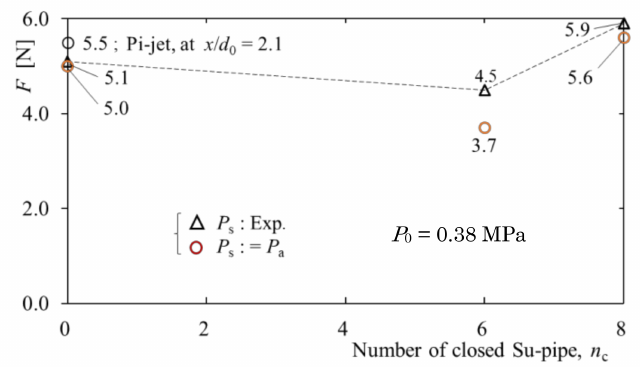
Figure 10. Thrust, F , of the supersonic jet from the FC-nozzle: The thrust of the 8-closed case is greater than that of the 0-closed case, and this seems to be due to the jet approaching proper expansion.